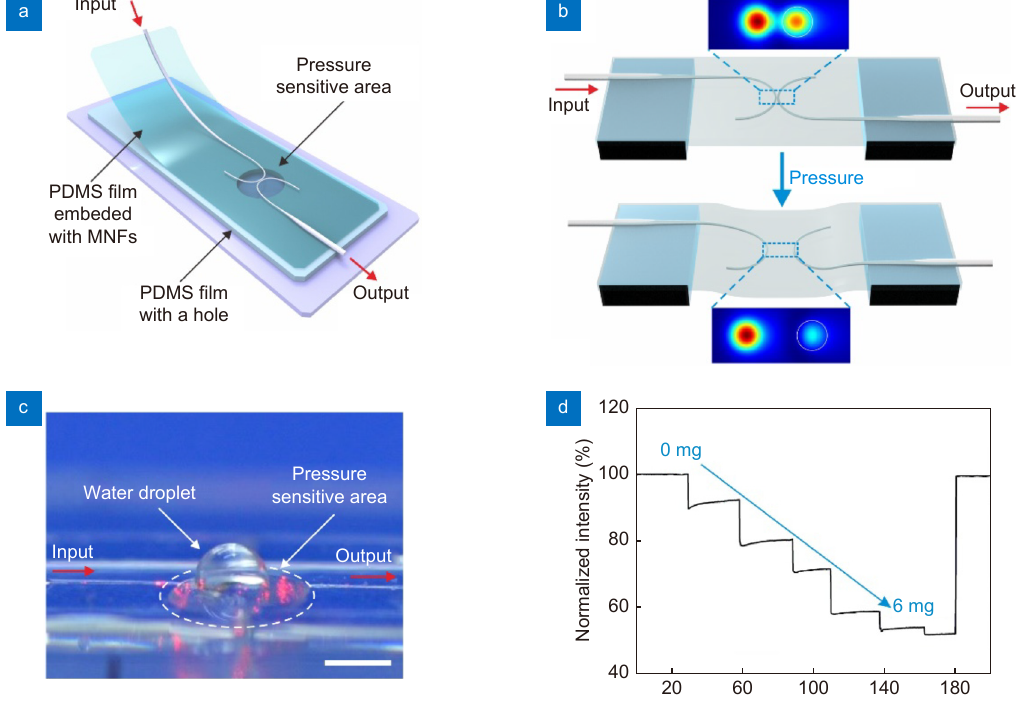
Fig. 3 | Weak pressure signal detection. ( a ) Schematic diagram of the sensor structure. ( b ) Schematic diagram illustrates the pressure sensing mechanism. The vertical deformation of the film due to the exerted pressure causes the elongation of film. The enlargement of gap width results in a drop of coupling efficiency, as the simulated field distributions shown in the inset. The white circles indicate the location of MNFs. ( c ) A photo of the sensor with a water droplet on the pressure sensitive area, the scale bar is 1.5 mm. ( d ) The responses of the pressure sensor to water droplets with a maximum applied pressure of approximately 9